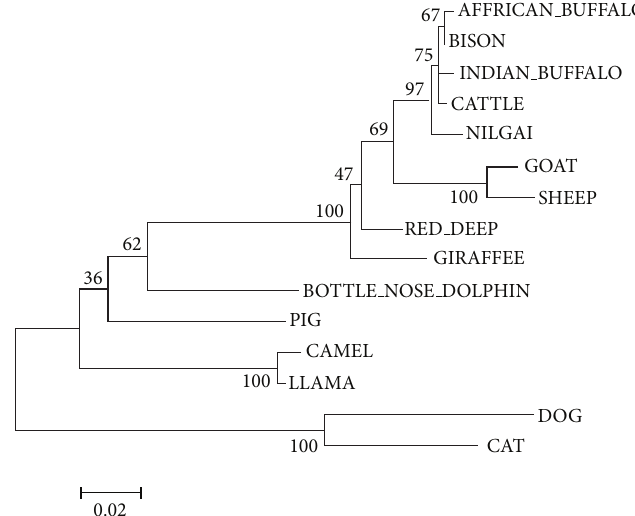
Figure 3: Phylogram illustrating the evolutionary relationship of nilgai and Indian buffalo IL-4 amino acid sequences with other species. The phylogenetic tree was constructed using neighbour-joining analysis. Numbers represent bootstrap values (given as percentages) for a particular node. 1000 replicates were used in bootstrap analysis for good statistical support. The branch lengths are scaled to represent the relative numberof substitutionsoccurringalong each branch. Thescale barindicates an evolutionary distance of0.02 amino acid substitutions per site for a unit branch